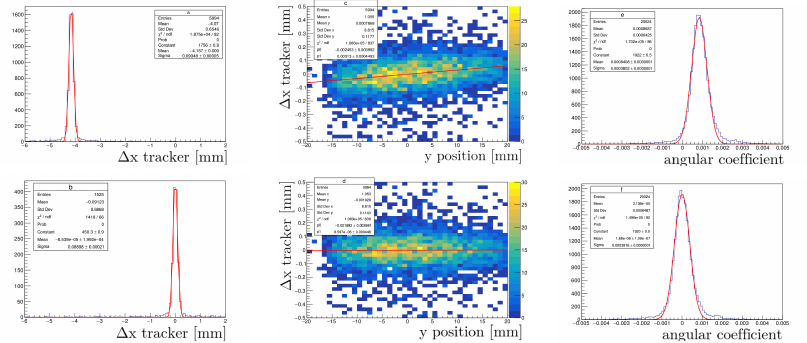
Figure 3: Plot used in the automatic alignment procedure for one view of one detector in the setup. On the top part the distributions are shown the distribution 1D and 2D before the alignment, on the bottom after the alignment. On the left side is shown the distribution of ∆ x trackers related to the shift alignment, in the middle the distribution of to removed the XY rotation, on the right the reconstructed angle of the ionizing track with respect to the tracking system. After the alignment the ∆ x trackers has to be centered in zero and it must not depend on the y detector . Similar plot are produced for the Y coordinate